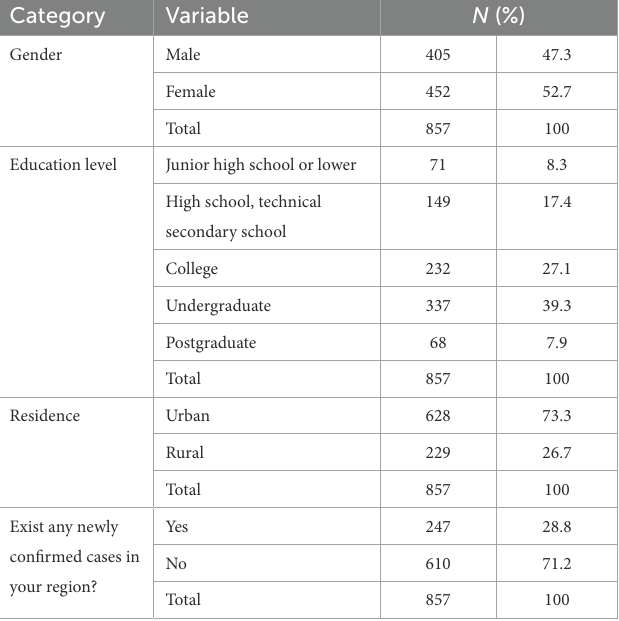
TABLE 1 Descriptive statistical analysis of